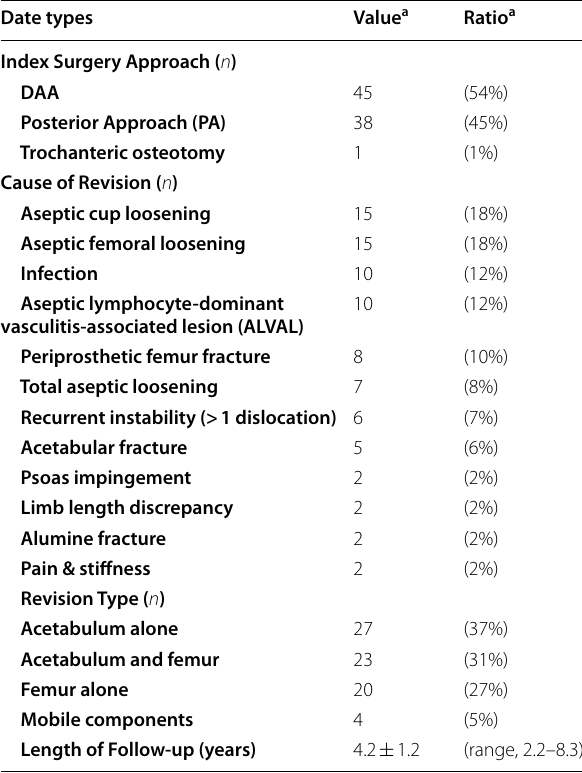
Table 2 Summary of the surgical data of our series